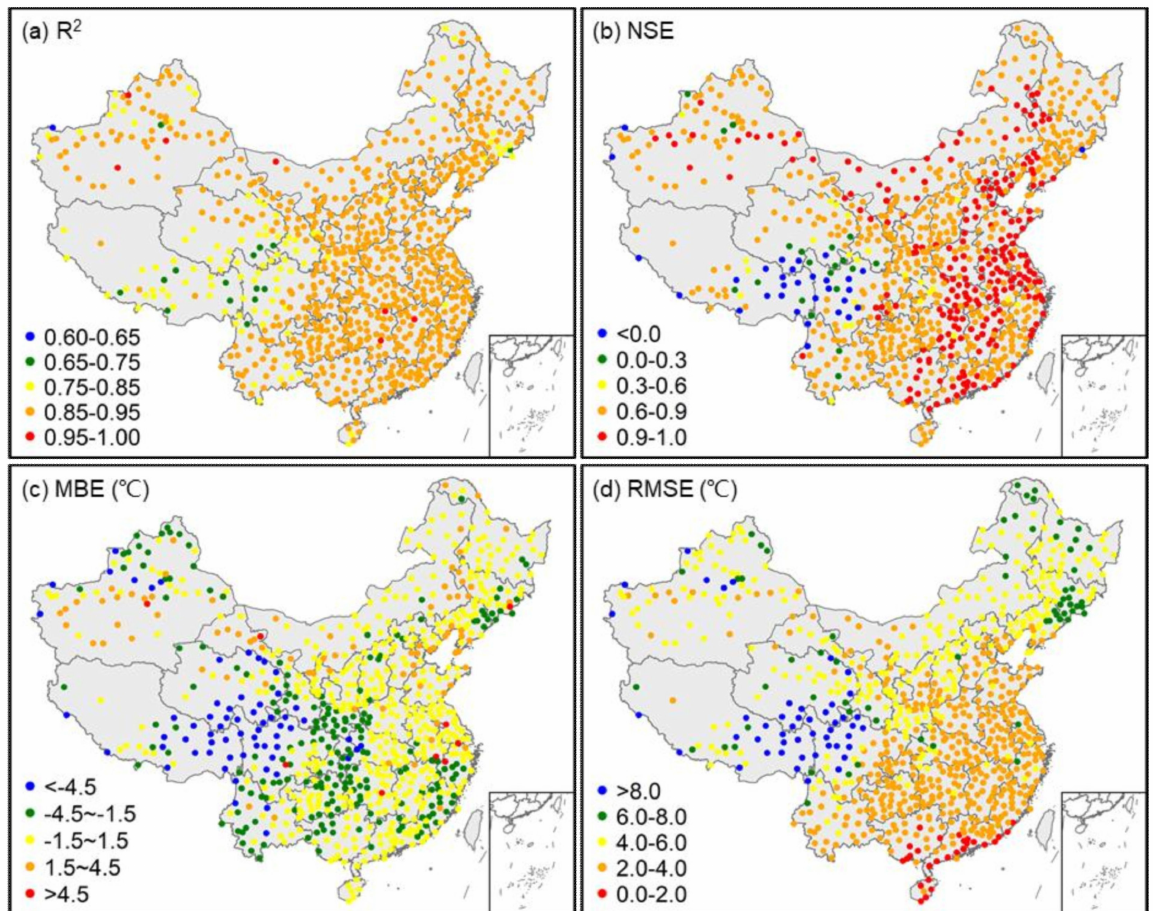
Figure 2. Statistical indices of the daily minimum T s from ERA5-Land against observed daily minimum GST from CMCD (V3.0) at 822 national surface weather stations in China. ( a ) R 2 , coefficient of determination; ( b ) NSE , Nash–Sutcliffe efficiency coefficient; ( c ) MBE , mean bias error; ( d ) RMSE , root mean square